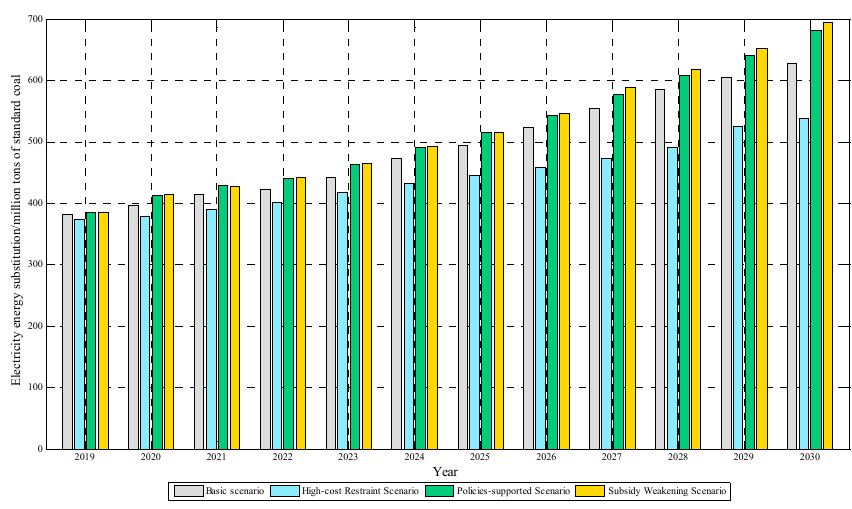
Figure 5. Forecasting results of electric power substitution under all scenarios (million tons of standard coal).